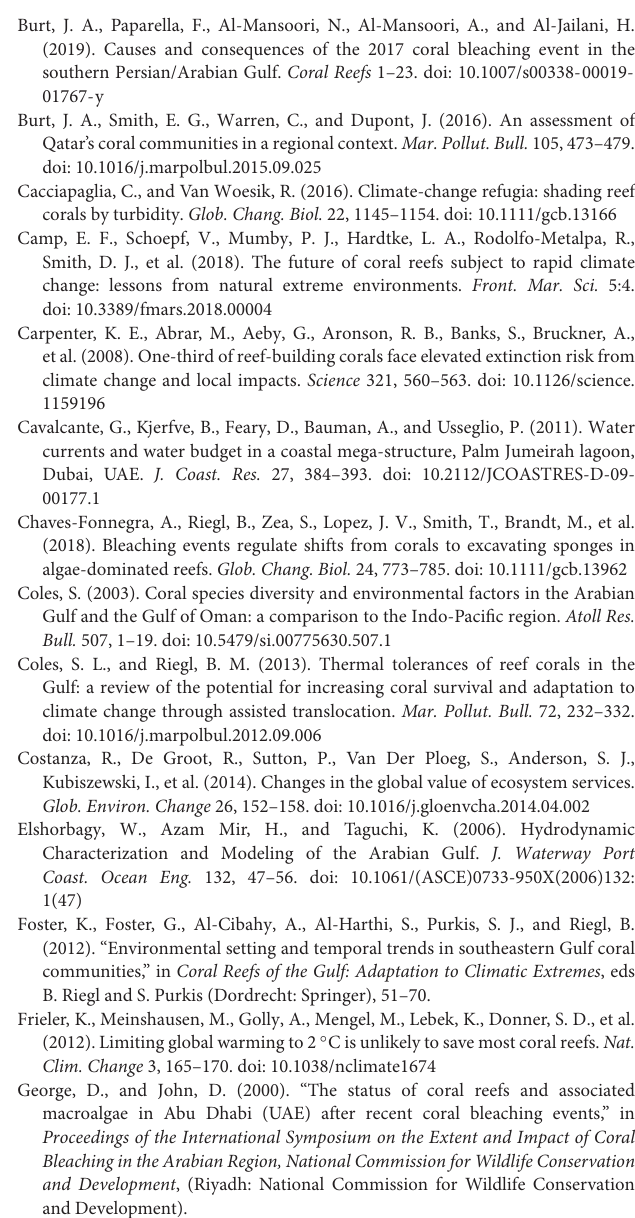
FIGURE S6 | Number of days that corals were exposed to a range of sea-bottom temperatures during summer (July 1 to August 31) for the decade from 2008 to 2017 at Ras Ghanada reef. (A) Total days over the entire summer, (B) maximum number of cumulative days at or above a given temperature. Both are based on 0.25 ◦ C temperature intervals. The 2012–2015 data are based on observed bottom temperatures on the reef, while the other years are simulated based on the ERA 5 dataset. FIGURE S7 | Number of days that corals were exposed to a range of sea-bottom temperatures during summer (July 1 to August 31) for the decade from 2008 to 2017 at Dhabiya reef. (A) Total days over the entire summer, (B) maximum number of cumulative days at or above a given temperature. Both are based on 0.25 ◦ C temperature intervals. The 2012–2015 data are based on observed bottom temperatures on the reef, while the other years are simulated based on the ERA 5